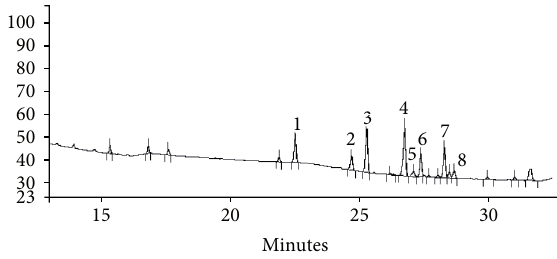
F 3: Chromatographic pro�les of coriander cake of sterols. Peaks numbers corresponding to: 1: cholestanol, 2: